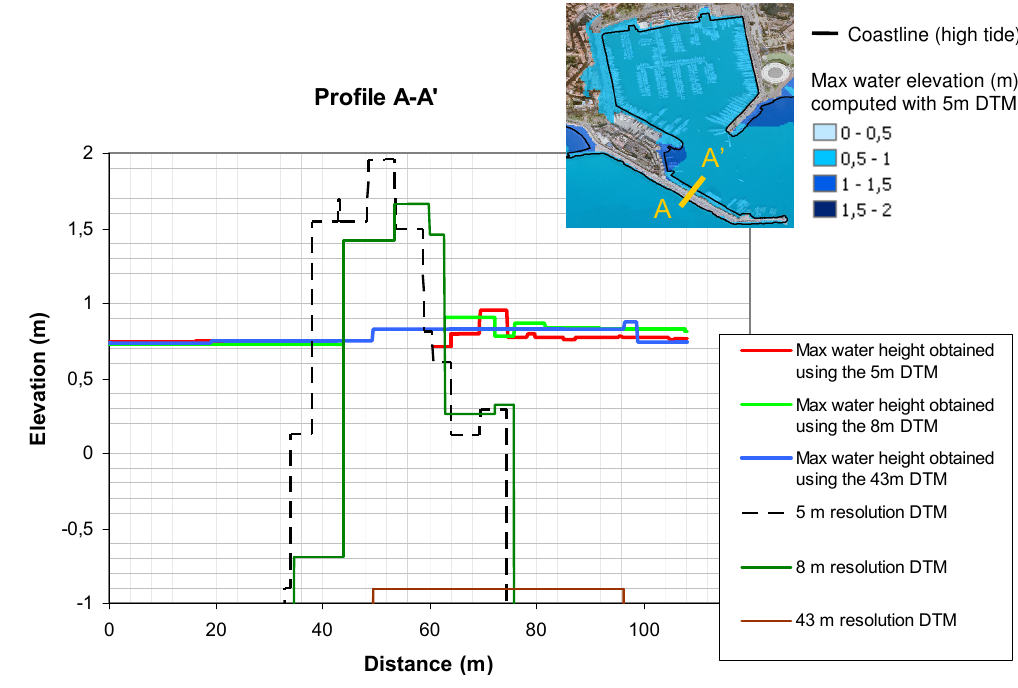
Fig. 4. Vertical profile across a bank of a Cannes (France)